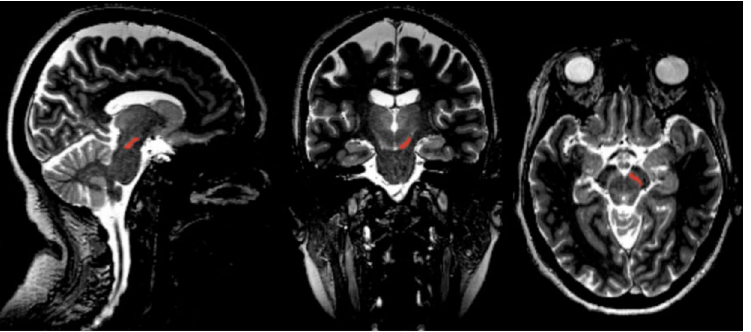
Figure 1. Manual segmentation of an individual SN/VTA. Within the midbrain, the SN/VTA can be identified as bright stripe on MT-weighted images. Bilateral SN/VTAs were defined as ROIs, which were used to quantify mean MT and R2* values. For illustration purposes, only the right SN/VTA is marked in red (i.e.,